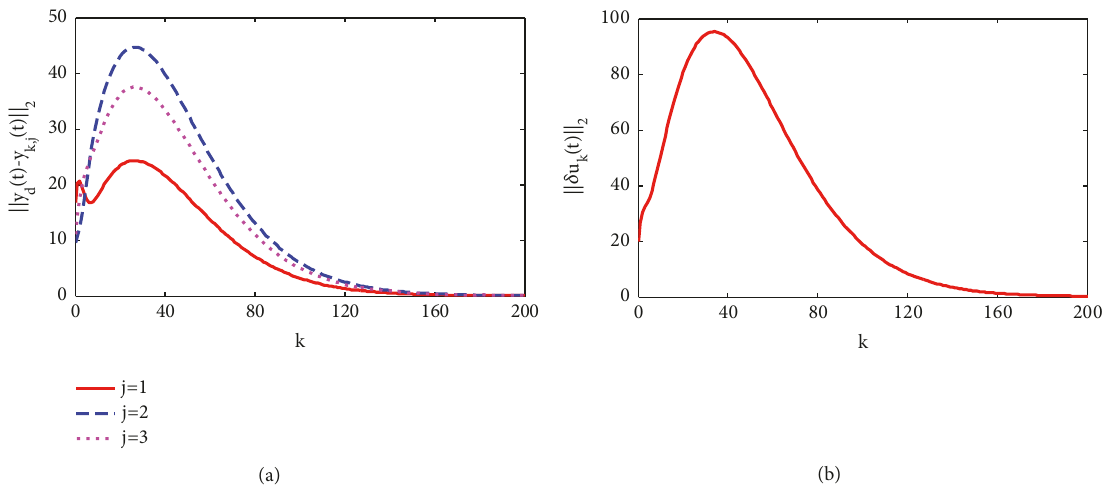
Figure 3: Under the observer (6) and the controller (11) with 𝐾 = [0, 0] and Γ = [−0.6908,0.3945] : (a) output tracking errors versus iteration numbers; (b) Input errors ‖𝛿𝑢 𝑘 (𝑡)‖ 2 versus iteration numbers (color online).